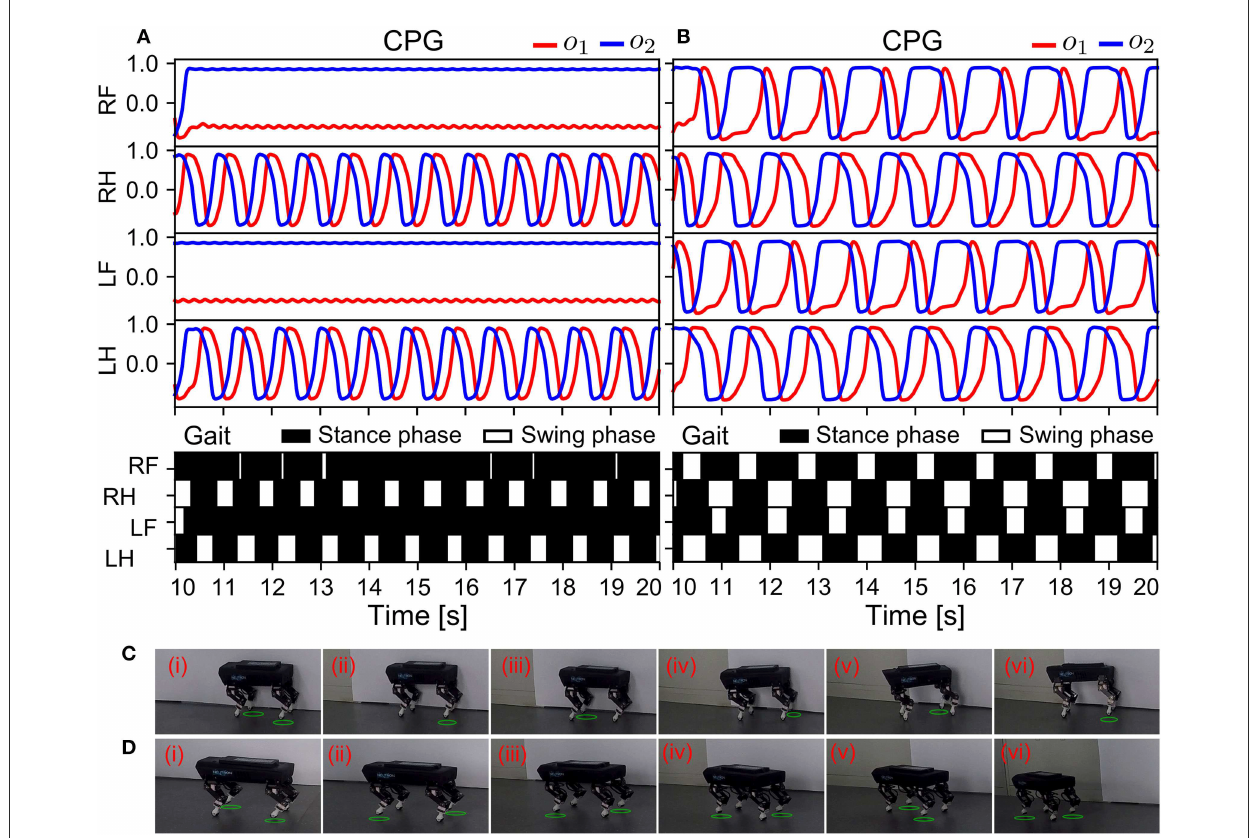
FIGURE11 Real-time data of the robust locomotion and robot behavior negotiating a sensor malfunction (in S2). The experiment was conducted using the control without and with the ANC. The results are shown in (A, B) , respectively. (C, D) Snapshots of Lilibot under the adaptive neural control without and with the ANC, respectively. A green circle under a foot indicates the foot was in a swing phase.